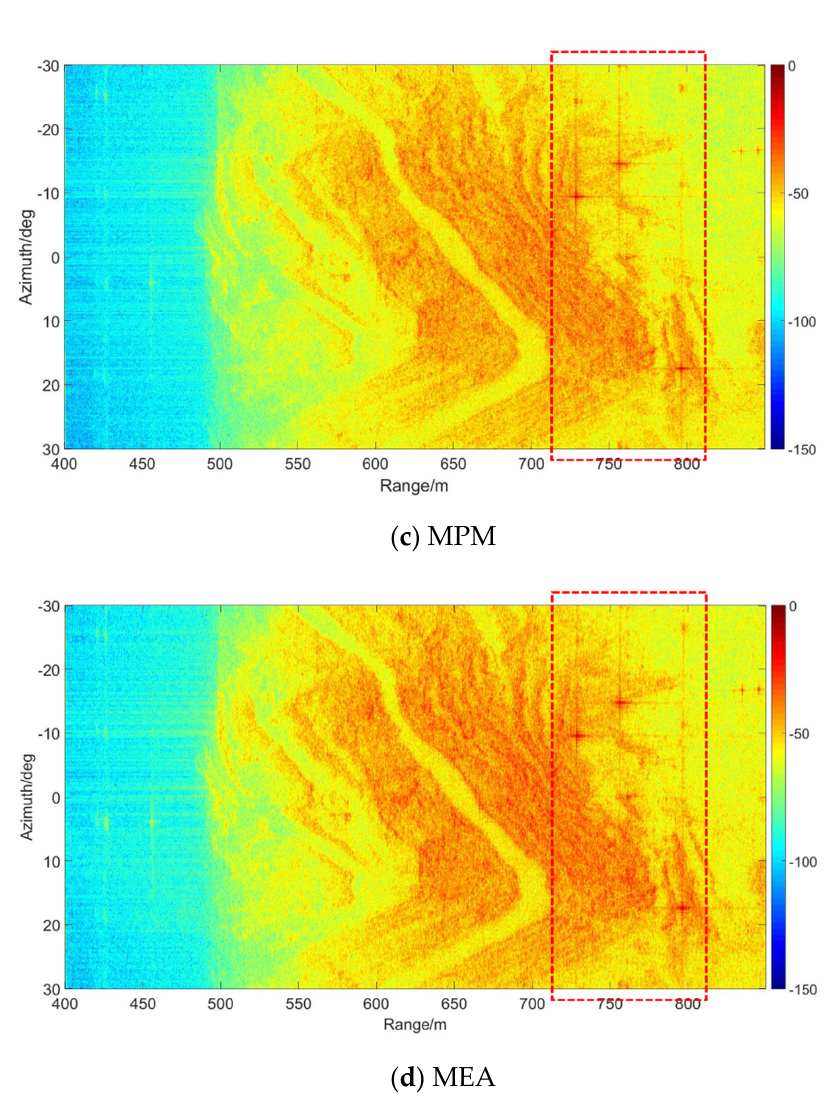
Figure 11. Radar images with different calibration methods ( a ) without calibration ( b ) SPM ( c ) MPM ( d ) MEA